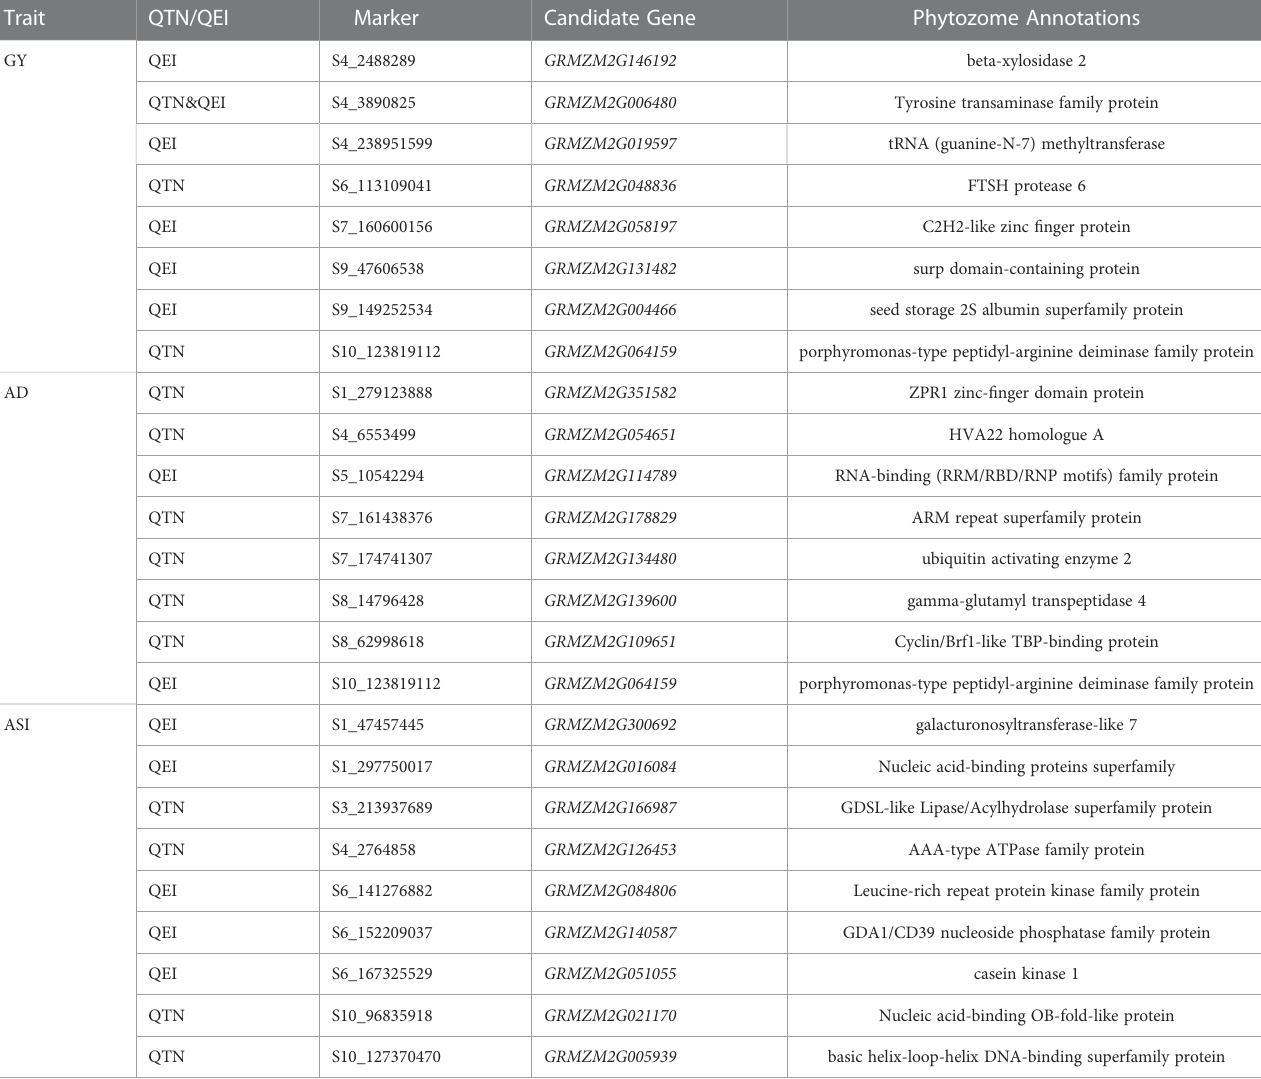
TABLE 2 Results of 24 candidate genes and functional annotation of Arabidopsis homologous genes.